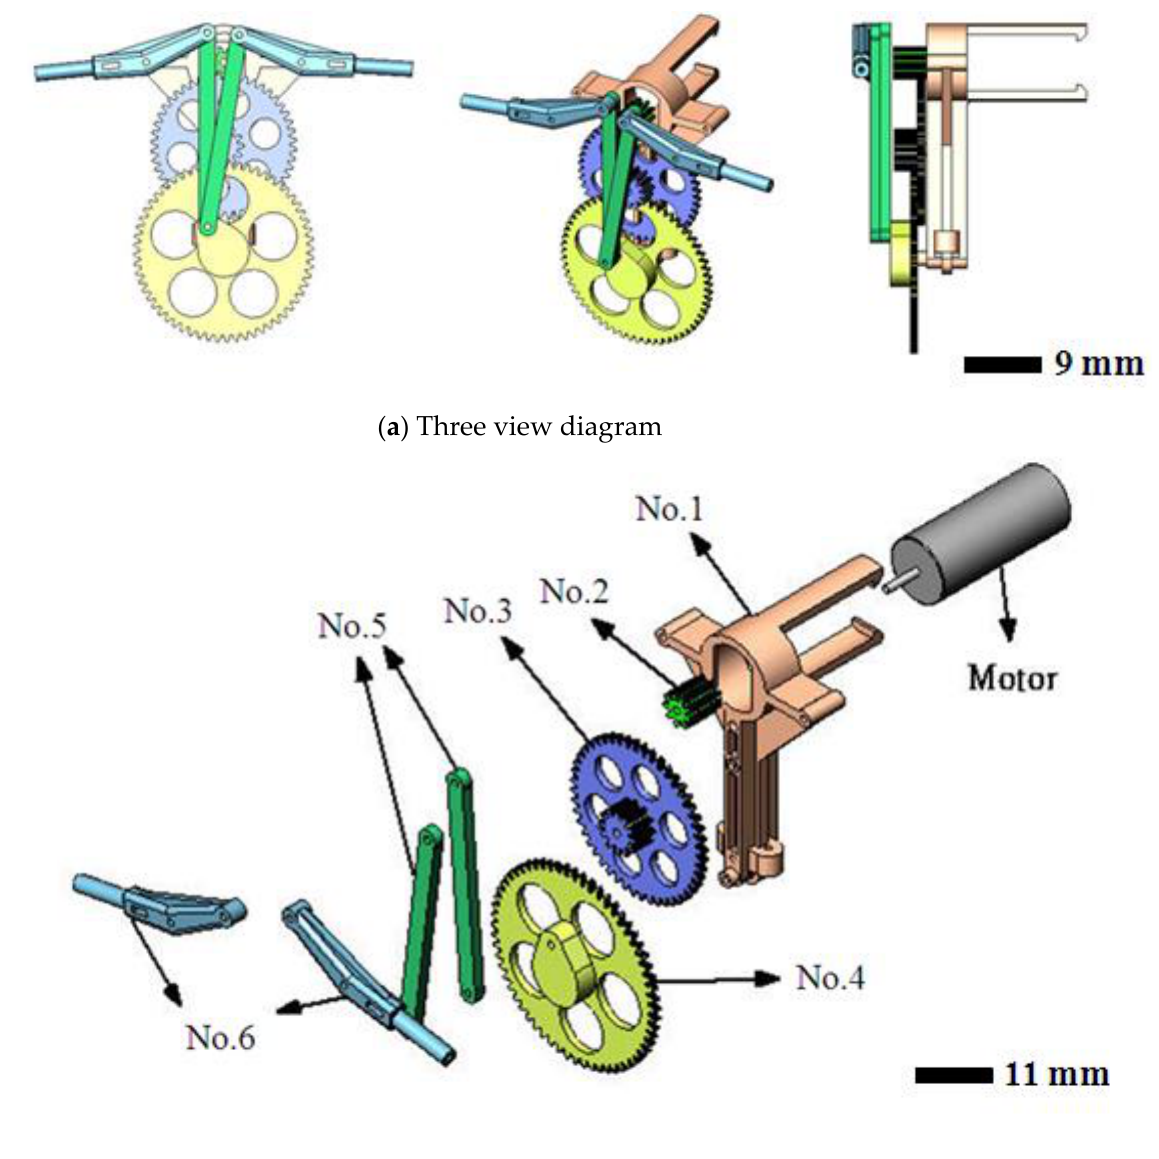
Figure 1. Product of the original flapping-wing MAV.